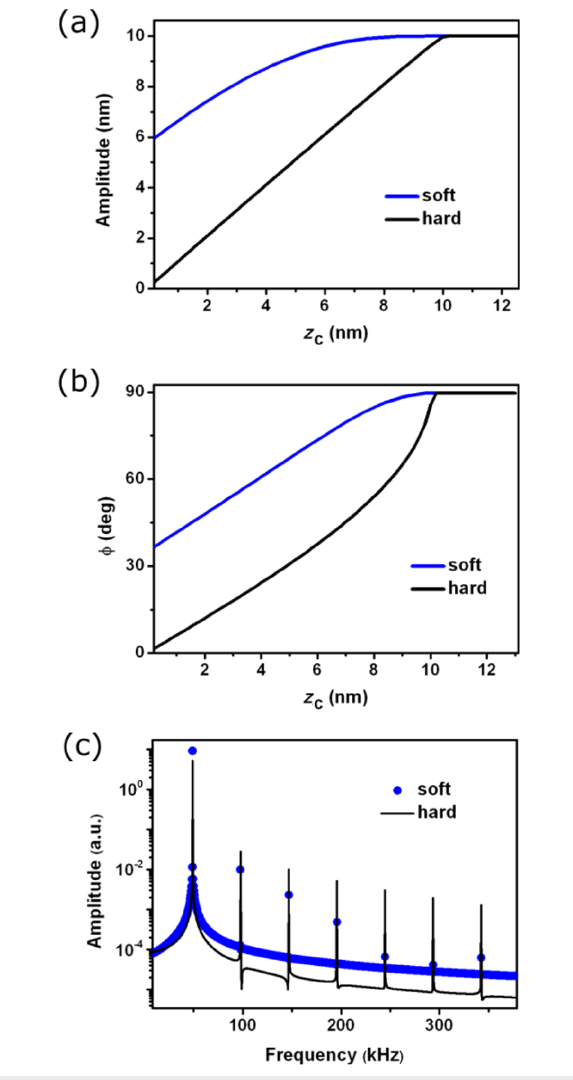
Figure 4: AM-AFM comparison of cantilever dynamics, hard versus soft materials. (a) Amplitude versus average tip–surface distance curves for hard and soft surfaces. (b) Corresponding phase shift curves. (c) Spectra of the amplitude components taken at z c = 5 nm. force increases until a maximum is reached. During